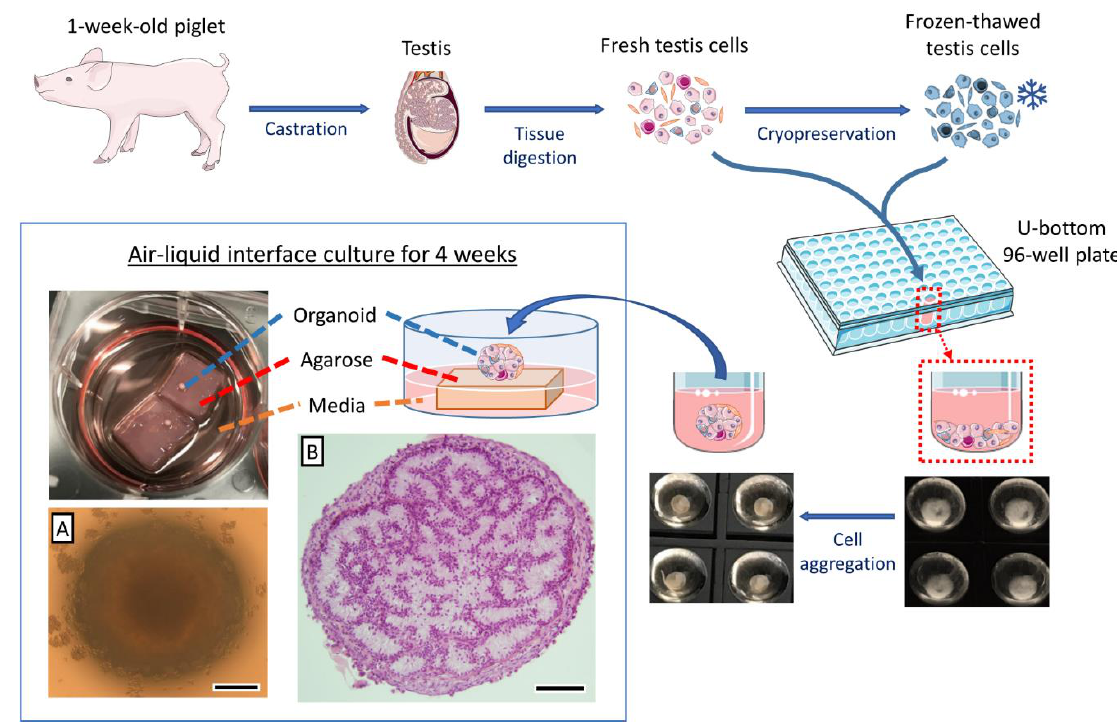
Figure 1. Schematic summary of the procedures for formation of testis organoids. Testis tissue was collected from 1-week- old piglets and digested to isolate testis cells. Testis cells were either used fresh for organoid formation or cryopreserved for later use. The fresh or frozen-thawed testis cells (1.0 × 10 6 cells/well) were then cultured in U-bottom 96-well plates for 24 h to form cell spheroids. The cell spheroids were subsequently cultured on small blocks (1 × 1 × 0.5 cm) of 1.5% agarose gel base immersed in media. The cell spheroids were further cultured for 4 weeks in this air–liquid interface culture system to form testis organoids, and the media were changed every other day. ( A ) Stereomicroscopic and ( B ) histological micrographs of testis organoids. Scale bars: 300 µm ( A ); 100 µm ( B ).